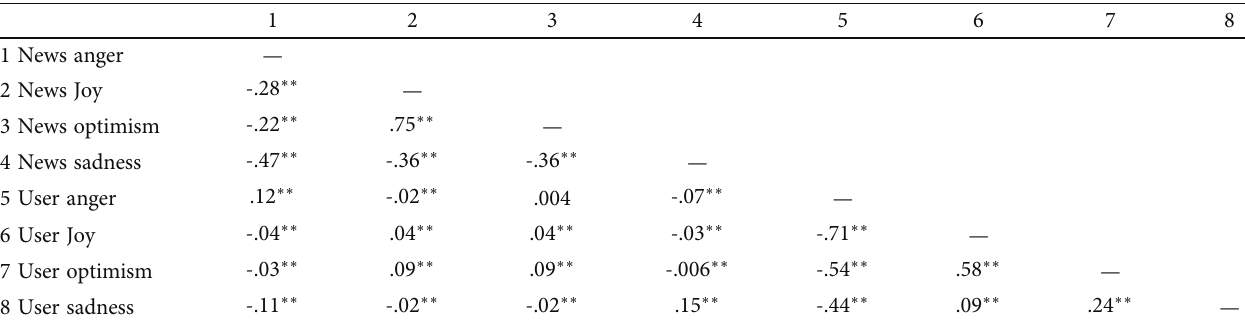
Table 7: The Daily Mail Online correlation matrix showing Spearman ’ s Rho coe ffi cients between news and user emotion scores.